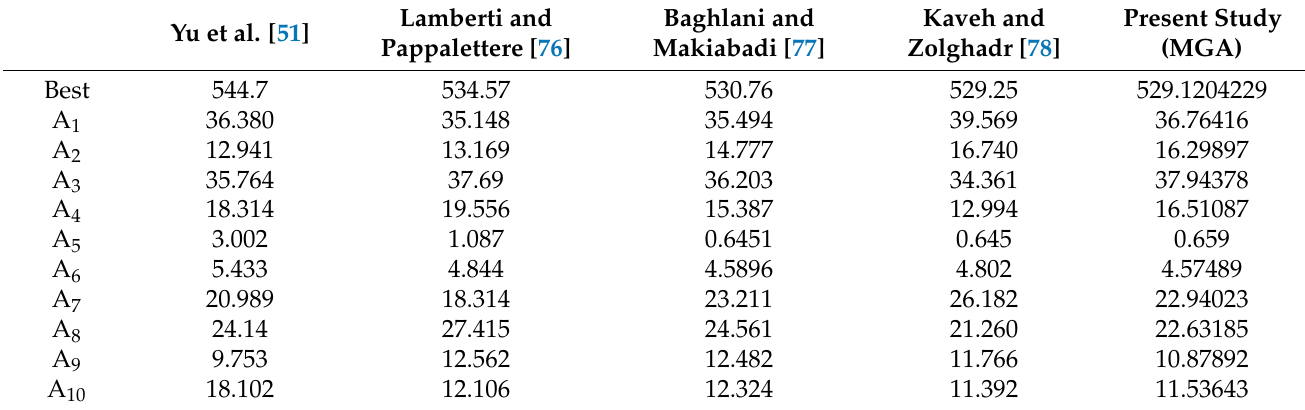
Table 19. Comparison of the best solutions for the ten-bar truss design problem.